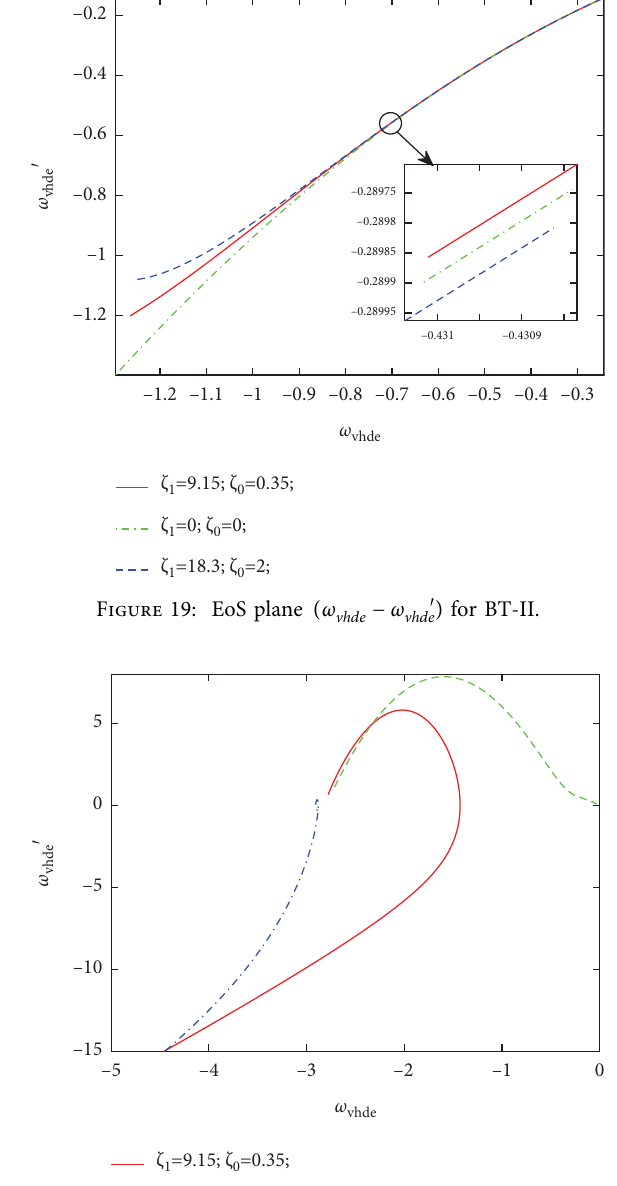
Figure 20: EoS plane ( ω